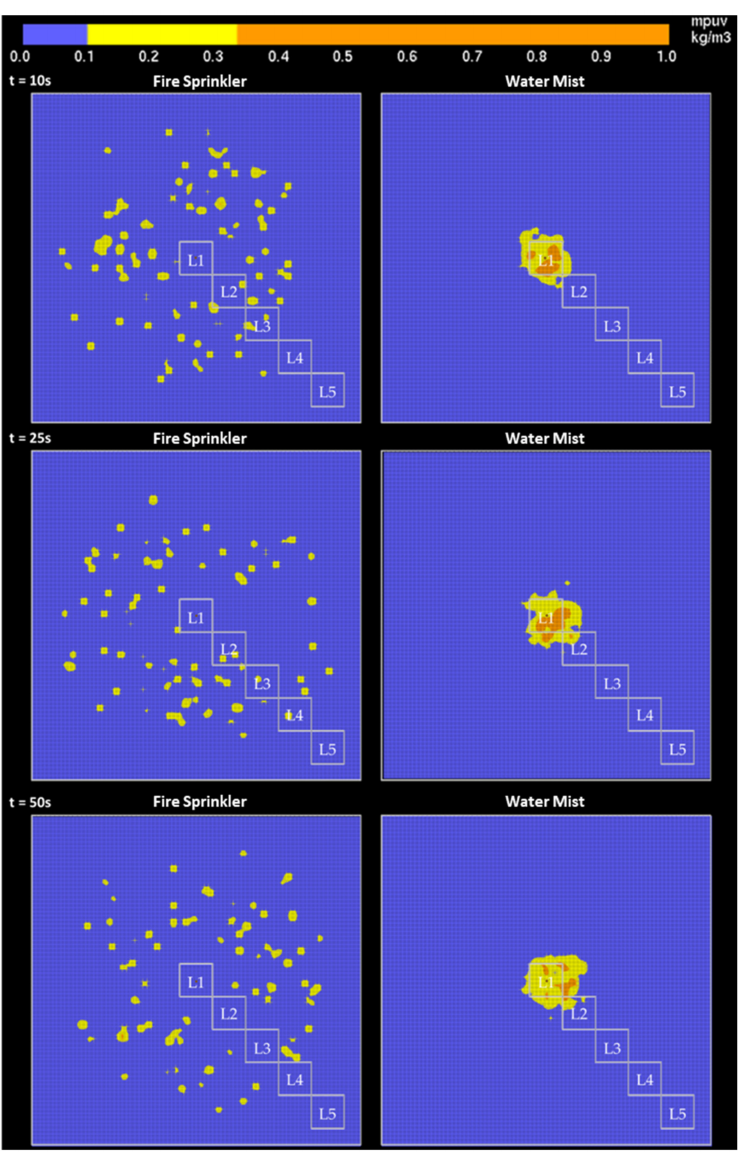
Figure 8. Density of water droplets sprinkled from sprinkler system and water mist system during the absent of